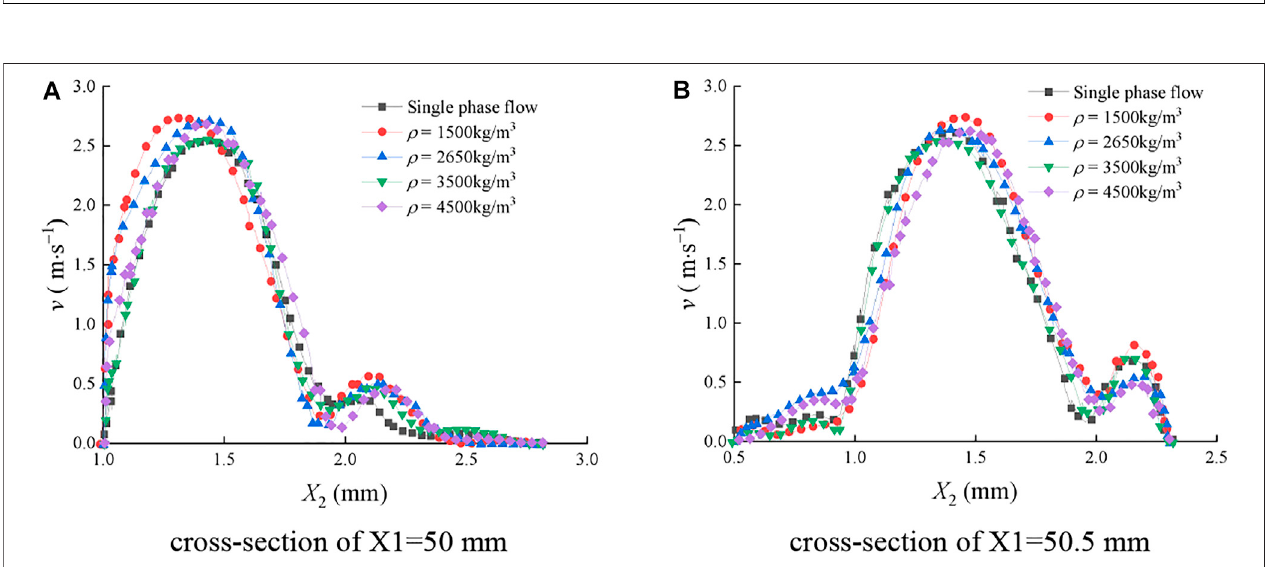
FIGURE 12 | Mean velocity distribution of the continuous-phase fl uid on cross sections of the rough fracture under different sediment particle mass density. (A) Cross section of X1=50 mm; (B) cross section of X1=50.5 mm.